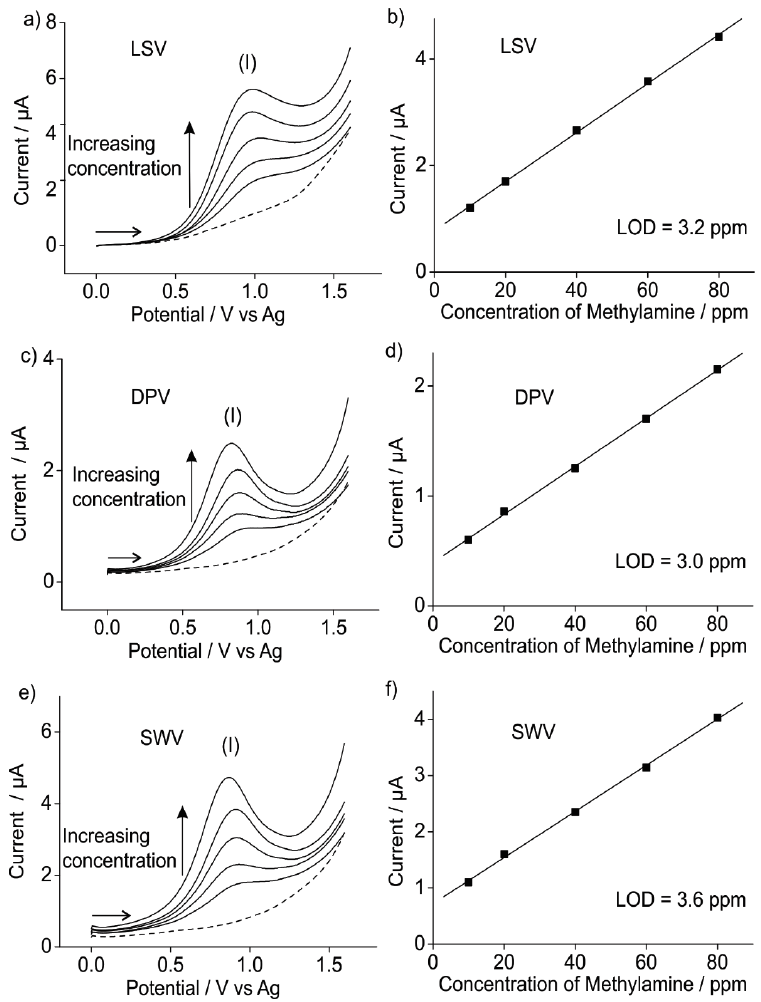
Figure 3. ( a ) LSV, ( c ) DPV and ( e ) SWV for the oxidation of methylamine gas at different concentrations (10, 20, 40, 60 and 80 ppm in the gas phase) on a Pt SPE in [C 2 mim][NTf 2 ]. Dashed line is the response in the absence of methylamine gas. The corresponding calibration plots obtained for ( b ) LSV, ( d ) DPV and ( f ) SWV using the peak currents from ( a , c , e ) are also